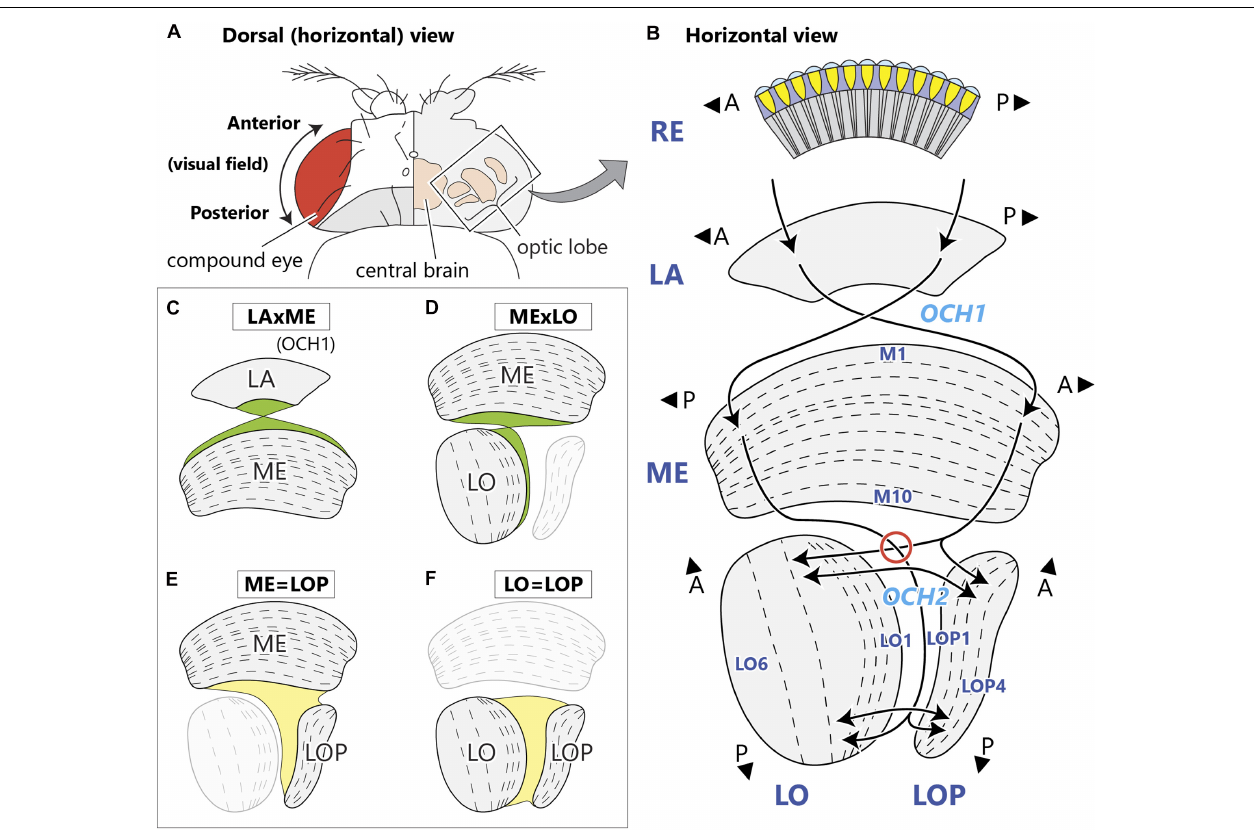
FIGURE 1 | Structure of the optic neuropils and their chiasmata. (A) Dorsal view of a fly’s head. The optic lobe forms a large part of the fly’s brain, and is situated lateral to the central brain in the head capsule, just beneath the retina of the compound eye. (B) A horizontal schematic view of the optic lobe and the topological projection patterns between the neuropils. The optic lobe comprises four stratified neuropils; the lamina (LA), medulla (ME), lobula (LO), and lobula plate (LOP). The outermost retina (RE) houses ommatidial clusters of photoreceptors that project directly to the lamina. Between the lamina and the medulla, the antero-posterior (A-P) retinotopic axis inverts via the first optic chiasm, OCH1, with the axons of lamina neurons decussating in the middle of the chiasm. Neurons corresponding to the posterior part of the visual field innervate the anterior part of the medulla. From there, neurons relaying the information project to the deepest (proximal) part of the lobula and lobula plate, traveling the longest path in the second optic chiasm, OCH2. Here, axons connecting the medulla and lobula decussate in the chiasm (red circle), while those between the medulla and lobula plate do not. Axons connecting the lobula and lobula plate run in parallel in the chiasm. A and P indicate anterior and posterior, respectively, both corresponding to the retinotopic orientation of the visual field. Names of representative layers according to Fischbach and Dittrich (1989) are shown. (C–F) Schematic views of chiasmal fiber projection patterns between the neuropils depicting the projection of OCH1 fibers (C) , and corresponding to the three projection patterns of OCH2 neurons (D–F)